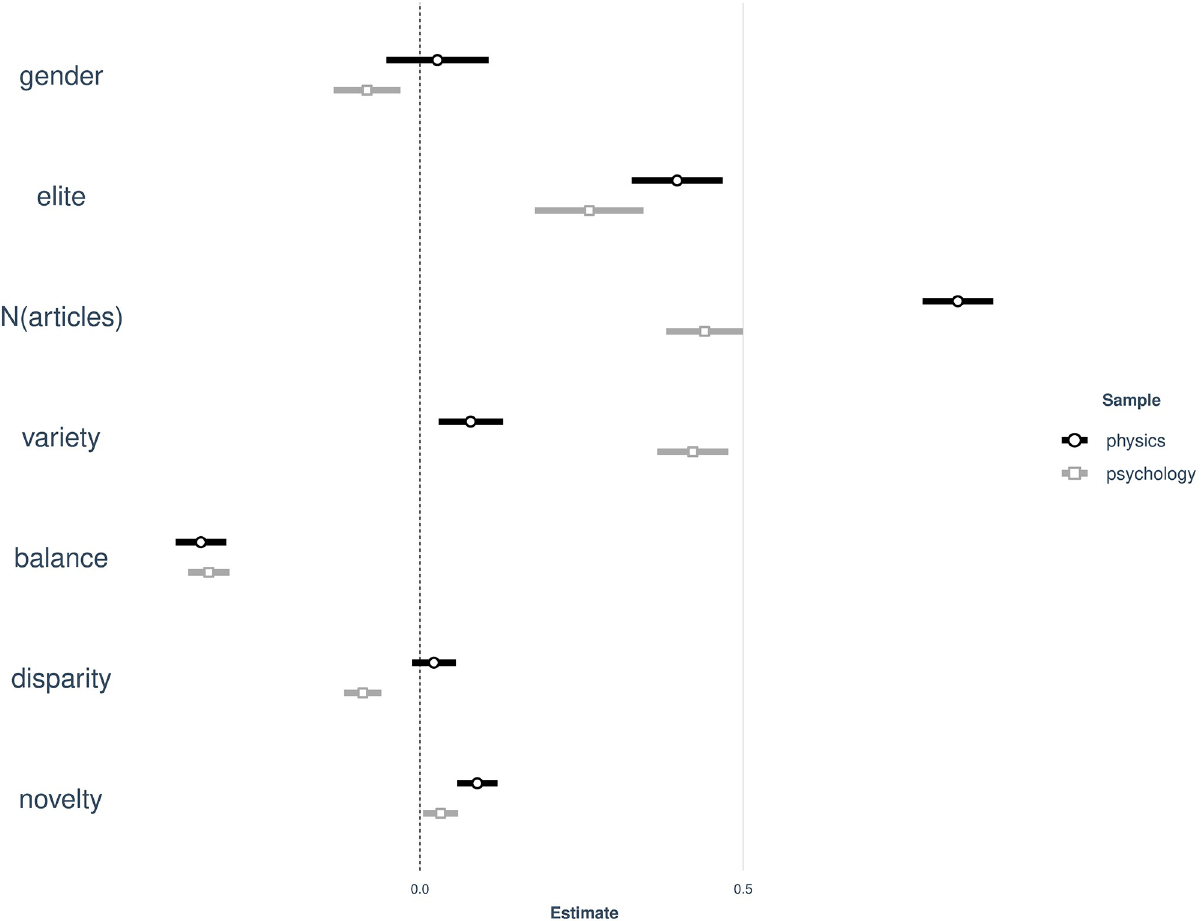
Fig 6. Main effects of regression. Main effects for physics and psychology (95% confidence